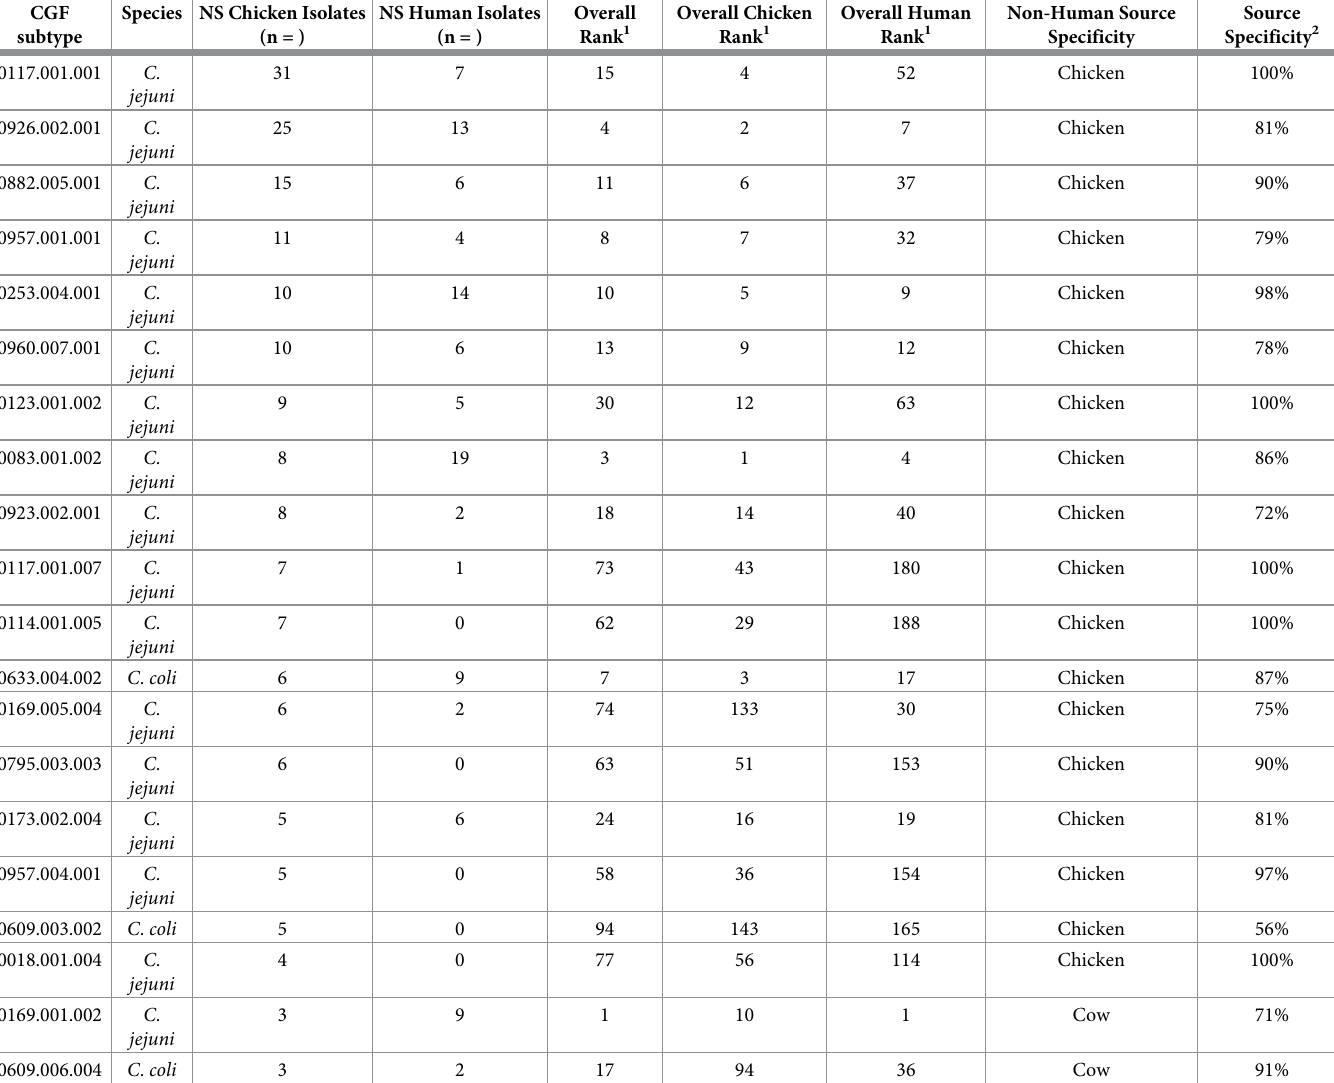
Table 2. Characteristics of the top 20 CGF subtypes observed among the chicken isolates collected in this